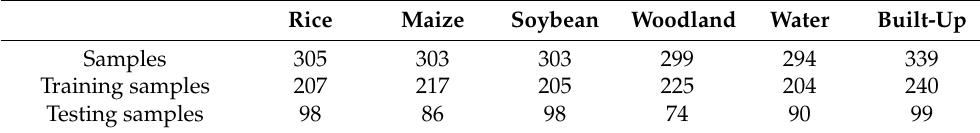
Table 2. Summary of the number of samples used per class for classification training and